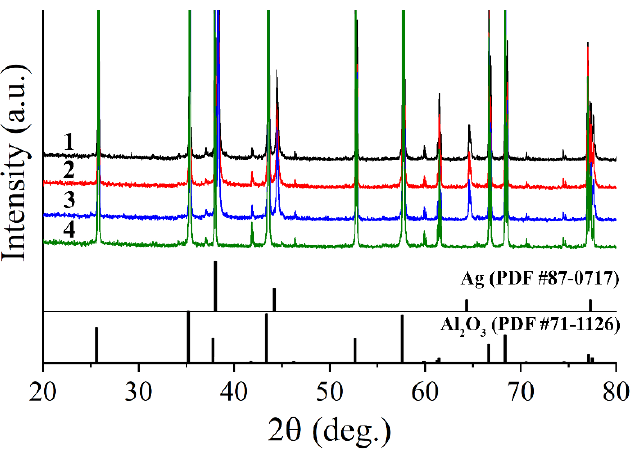
Figure 3. X-ray diffraction patterns of Ag films grown on the surface of Al 2 O 3 substrates at different temperatures (1—100, 2—120, 3—140 °C) as well as a diffractogram of the original Al 2 O 3 substrate (4).